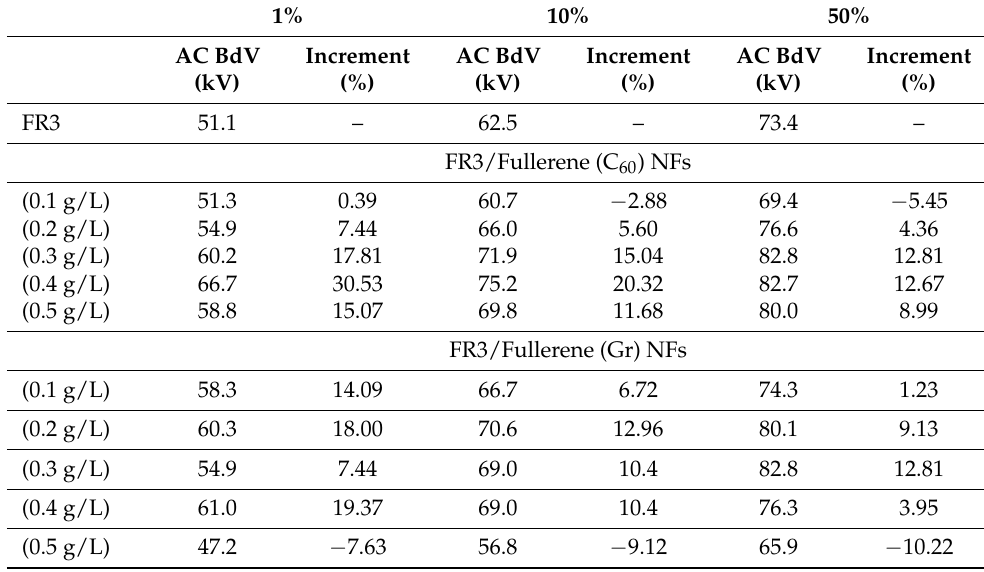
Table 7. The AC breakdown voltage for different probability levels, evaluated using Weibull fit curves.